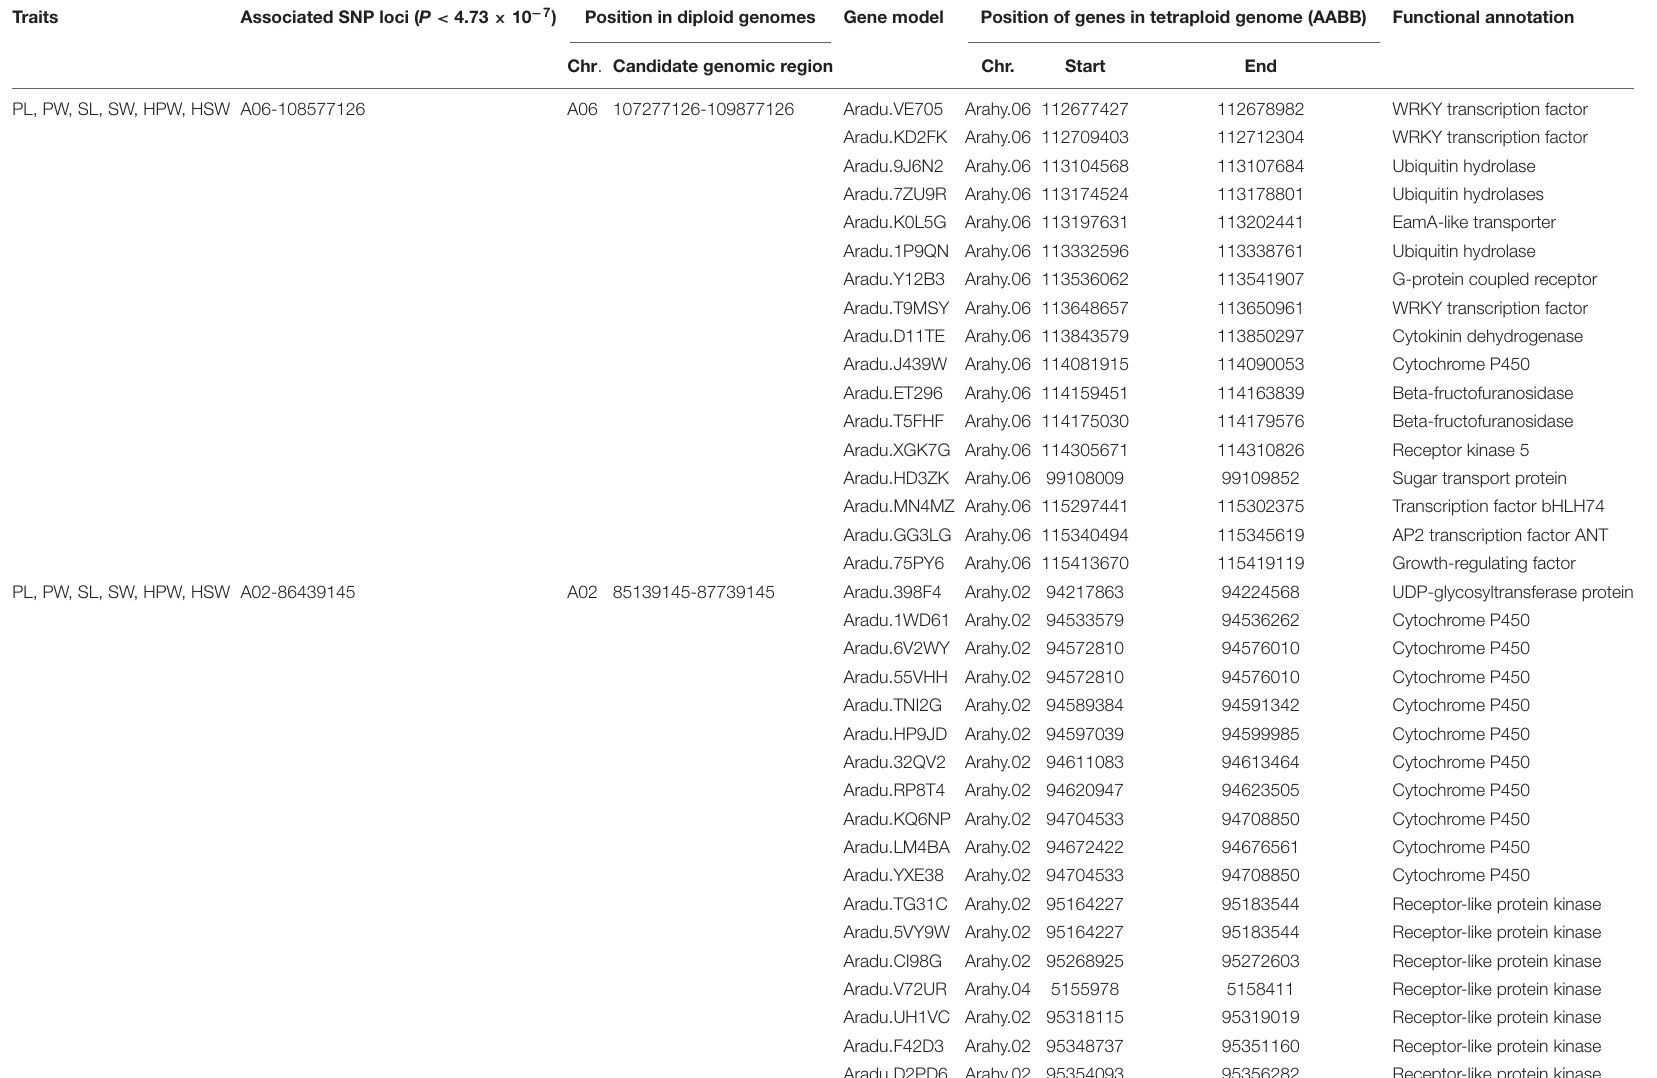
TABLE 4 | The putative candidate genes in the two stable and major candidate genomic regions.